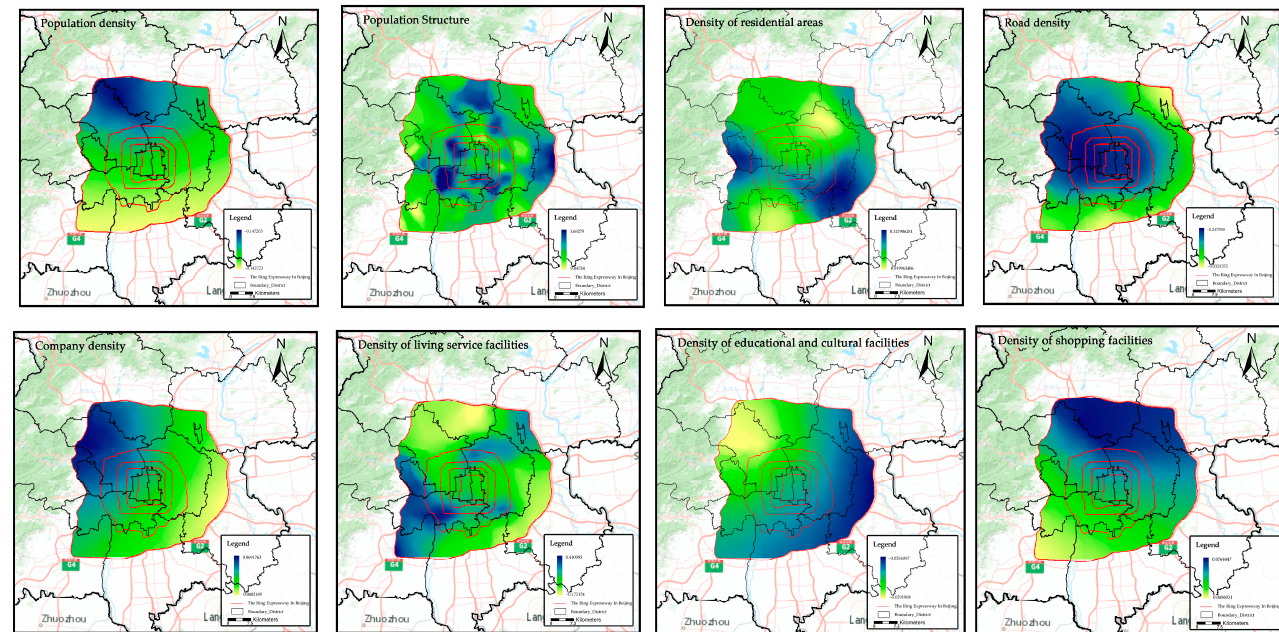
Figure 9. MGWR local coefficient kriging interpolation analysis results.